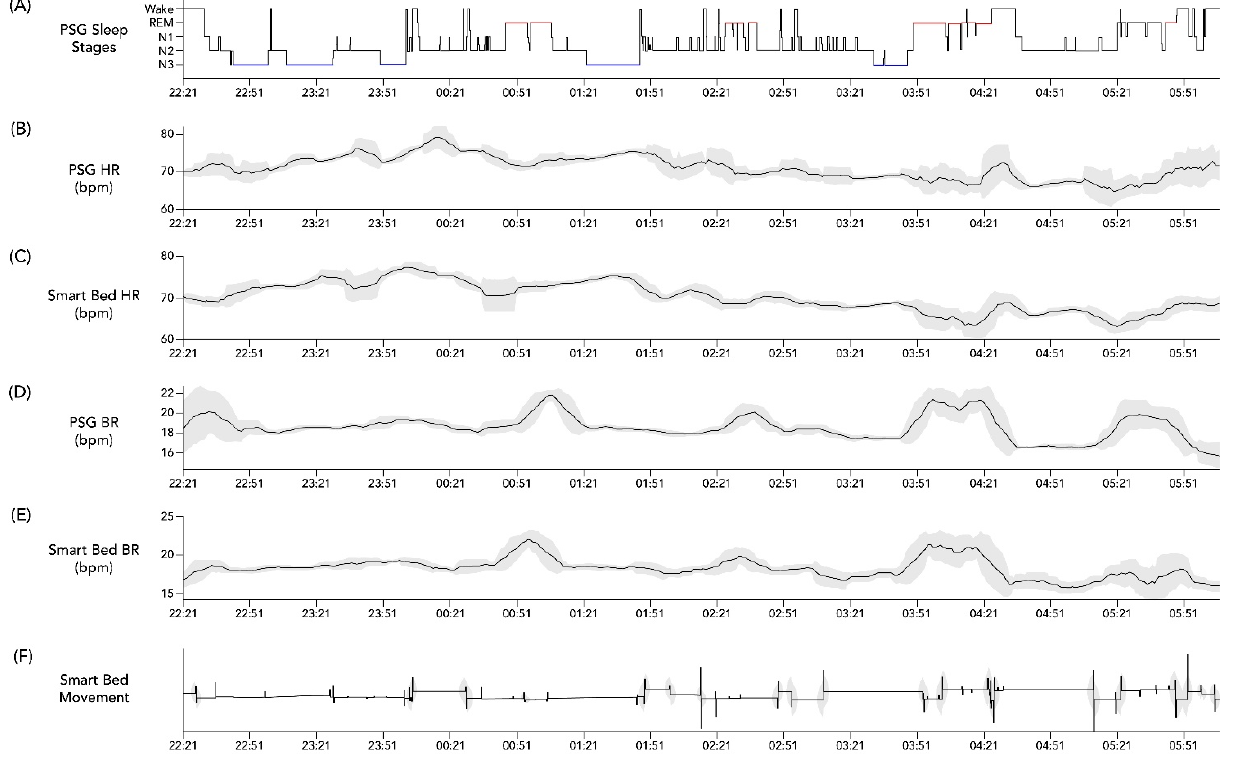
Figure 2. Example hypnogram from PSG and concurrent physiological data from PSG and the smart bed. Hypnogram data from a 36-year-old woman with BMI = 21.6 kg/m 2 ( A ) and simultaneous profiles of PSG HR ( B ), smart bed HR ( C ), PSG BR ( D ), smart bed BR ( E ), and smart bed movement ( F ). Variability in overnight HR and BR was calculated at each time point as the standard deviation of values recorded over a running 15 min window (shaded grey bands). A 15 min smoothing window was applied to the HR and BR profiles to remove sporadic spikes and highlight the overall trends. BMI, body mass index; bpm, beats/breaths per minute; BR, breathing rate; HR, heart rate; PSG, pol-